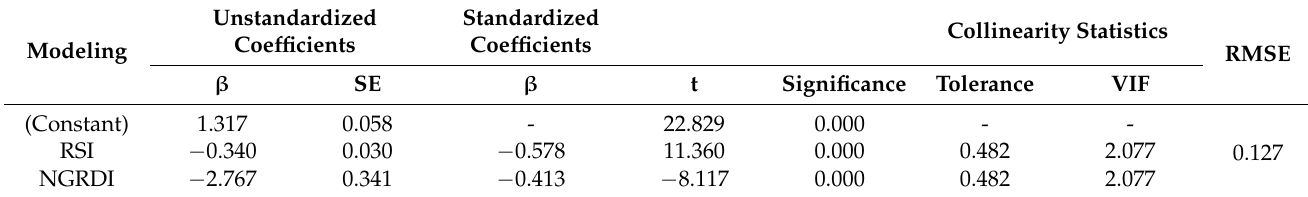
Table 6. Test results of the coefficients of the spectral index RSI and NGRDI models.